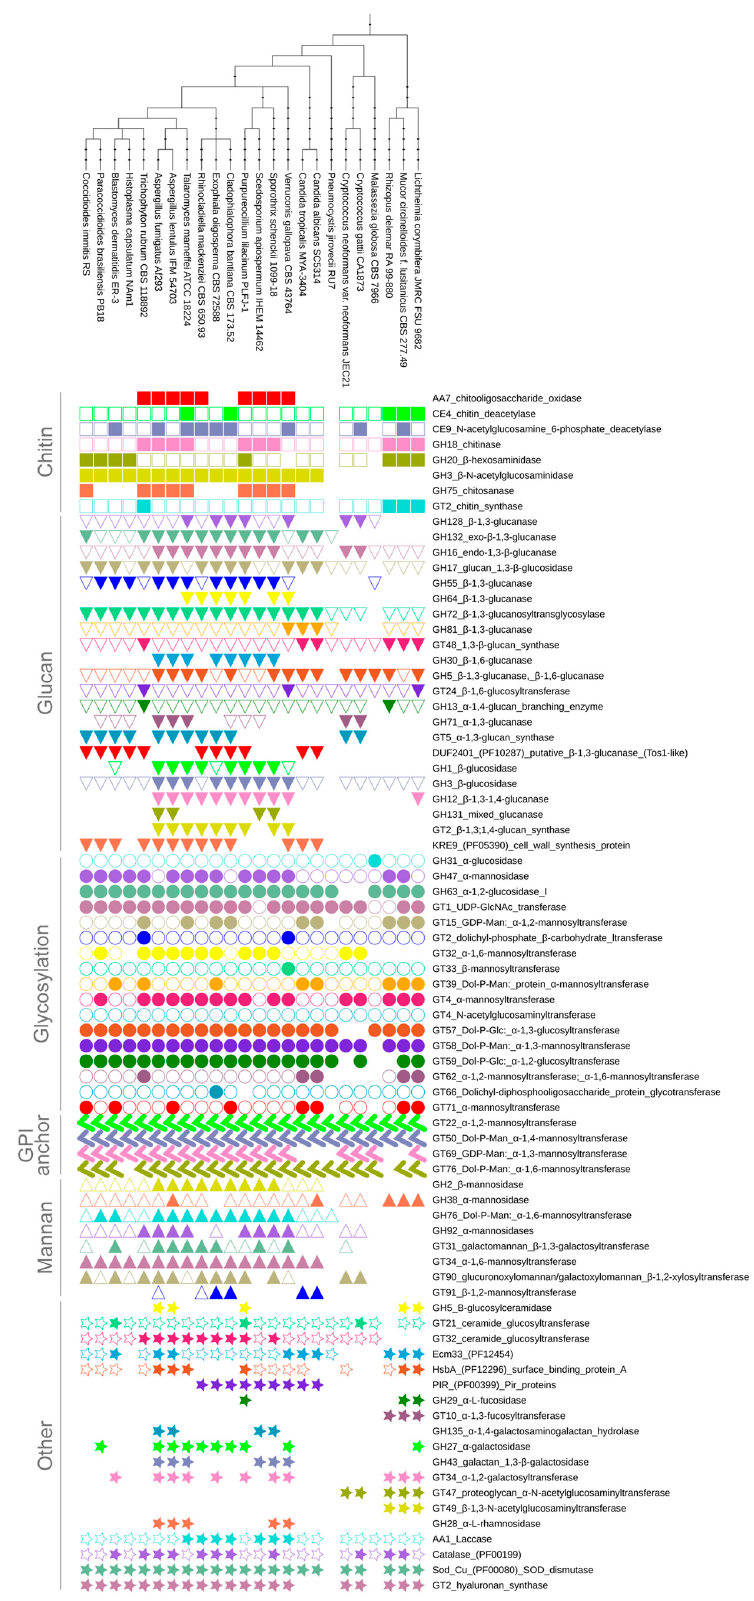
Figure 1. Summary of distribution of 78 CWP families in diverse pathogenic fungi. Filled shape—more homologs than average; empty shape—average number or less homologs; no shape—no homologs.